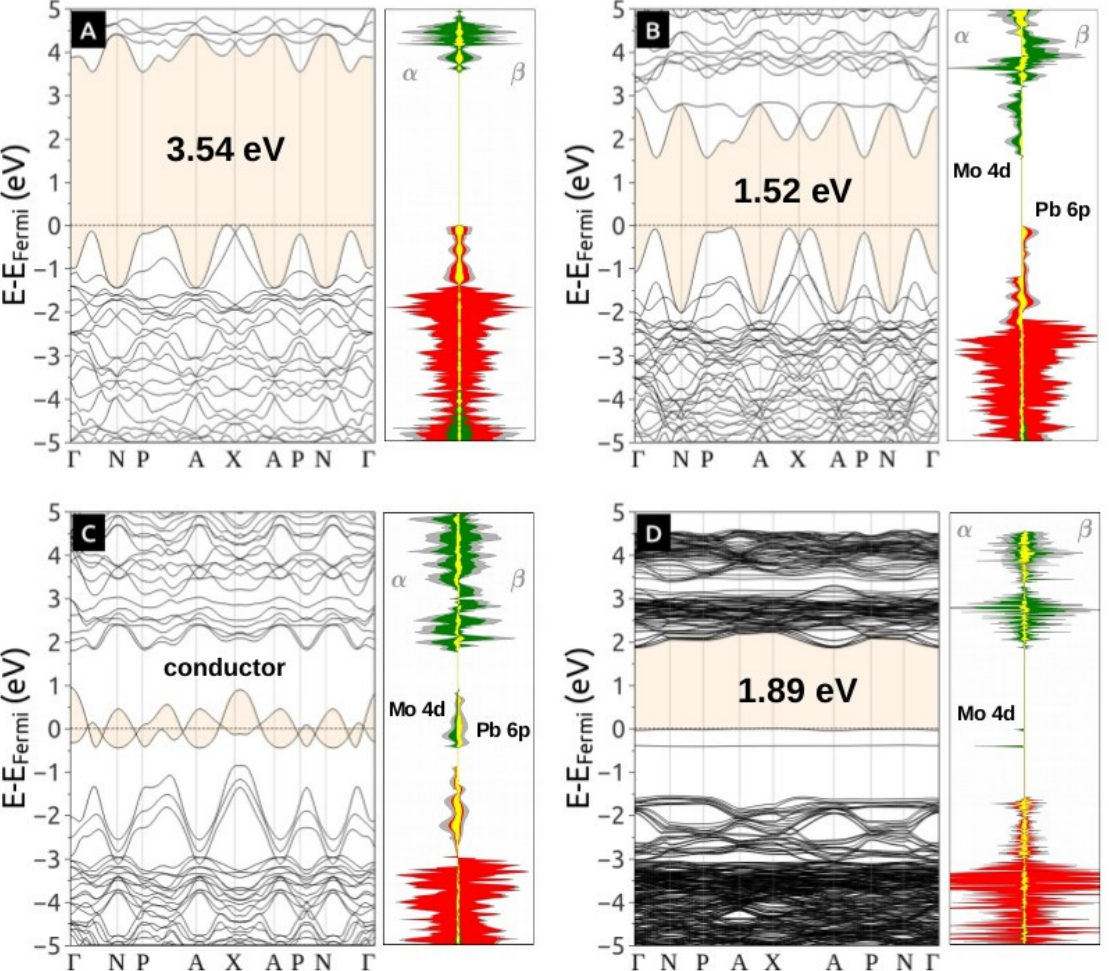
Figure 5. Band structure and projected density of states of stoichiometric PbMoO 4 in the ( A ) ground S 0 state, ( B ) triplet T 1 without symmetry broken, ( C ) triplet T 1 with symmetry broken (and fully relaxed), ( D ) reduced PbMoO 3.94 . The horizontal red line indicates the Fermi level. In all cases, alpha